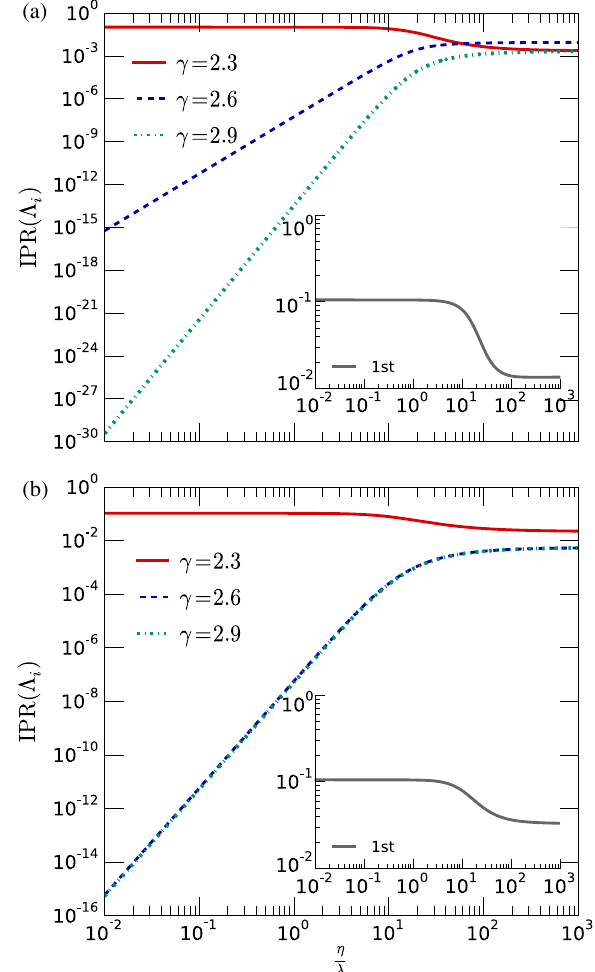
FIG. 17. Spectral properties of the tensor R ð λ ; η Þ as a function of the ratio η = λ for a multiplex with two layers with the same degree distribution (different random realizations of the configu- ration model) and connected to its counterpart on the other layer. In the top panel, we present the inverse participation ratio of the two larger eigenvalues and the individual-layer contributions, while in the bottom panel, we show the leading eigenvalues. Every curve is composed of 10 3 log spaced points, in order to have enough